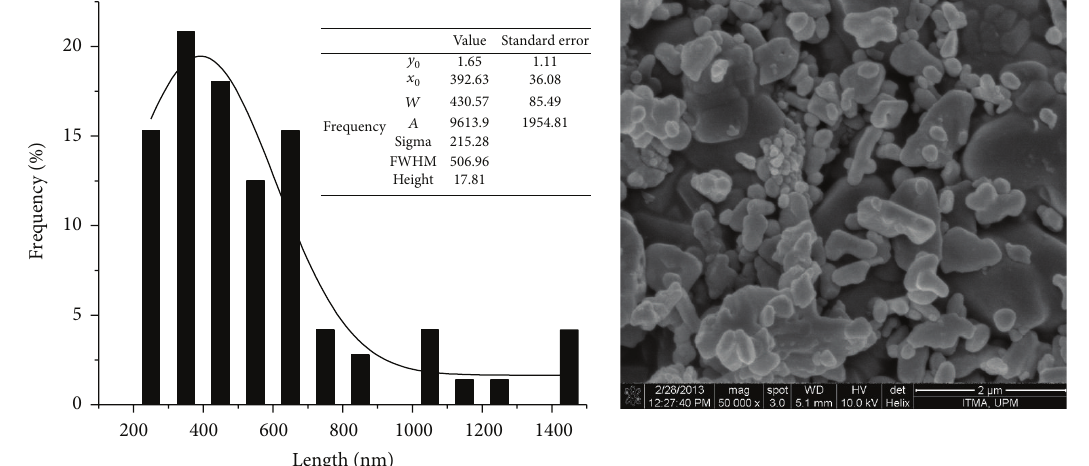
Figure 4: Grain size distribution of 3 wt% Er 3+ doped willemite-based glass-ceramic crystals in the glass-ceramic samples sintered at 900 ∘ C for 4h.